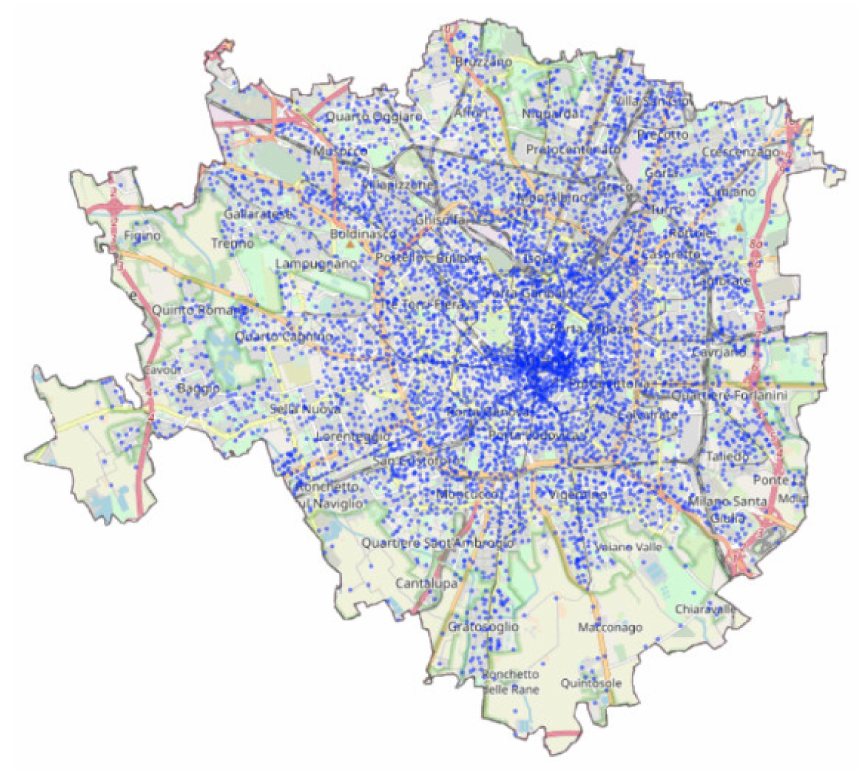
Figure 3. Secondary substations’ locations within the Milan area.